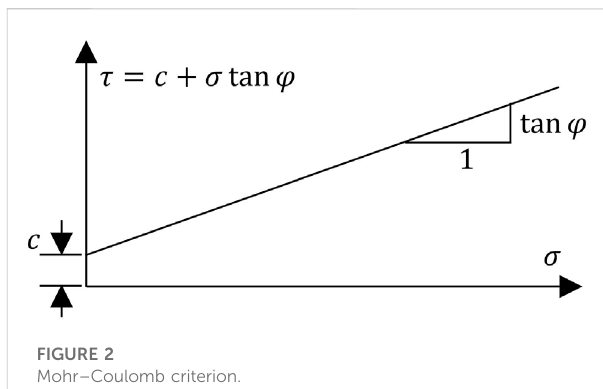
FIGURE 2 Mohr – Coulomb